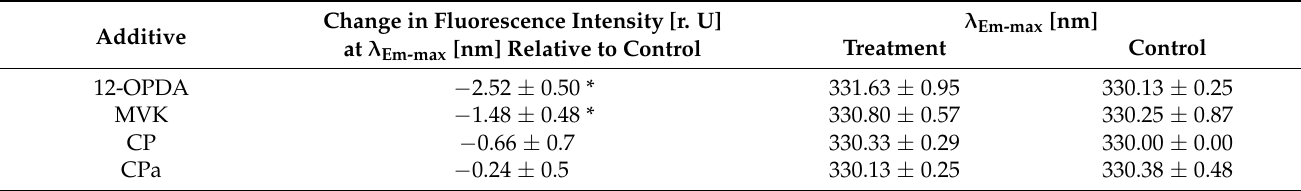
Table 3. Intrinsic protein fluorescence analysis of Cyp20-3 incubated with various CCCs. A total of 30 µ M Cyp20-3 was mixed with indicated compounds at a final concentration of 125 µ M in a quartz cuvette and analyzed for intrinsic fluorescence changes. Among the tested compounds, 12-OPDA and MVK changed the intrinsic fluorescence in comparison to the control. Data are means ± SD (n ≥ 6). Asterisks indicate significant differences at p ≤ 0.05. Statistical significance was calculated with one-way ANOVA with post-hoc Tukey HSD test. For details, see Section 2. Additive